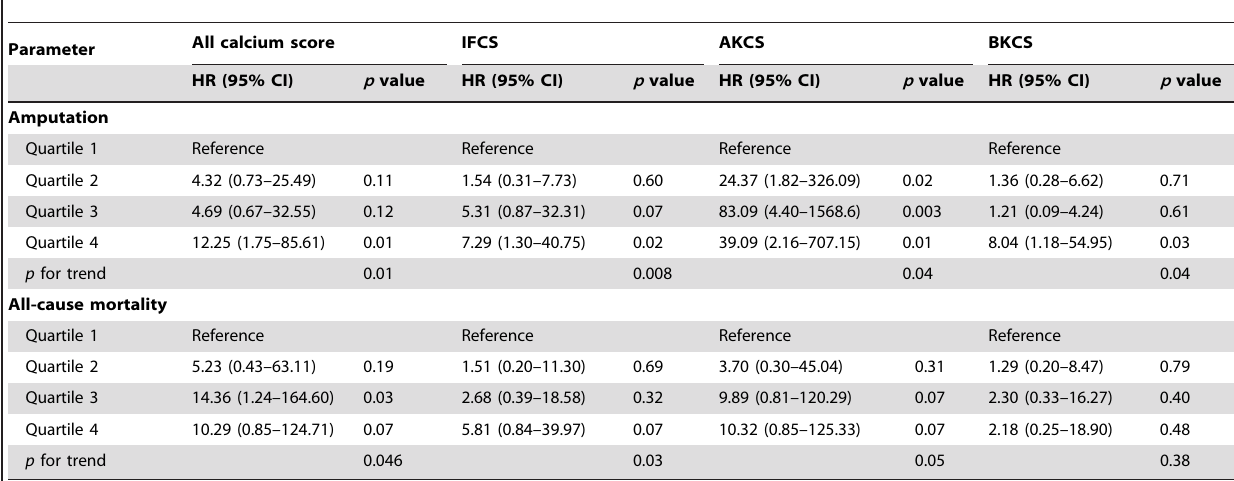
Table 3. Multivariate Cox proportional hazards analyses of calcium scores for lower extremity amputation and all-cause mortality.